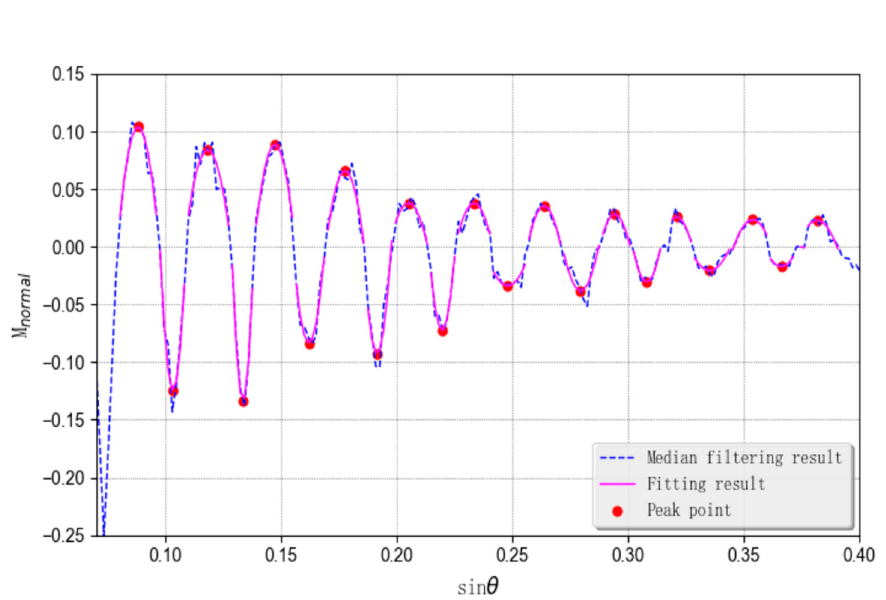
Figure 4. Median filtering and fitting results.